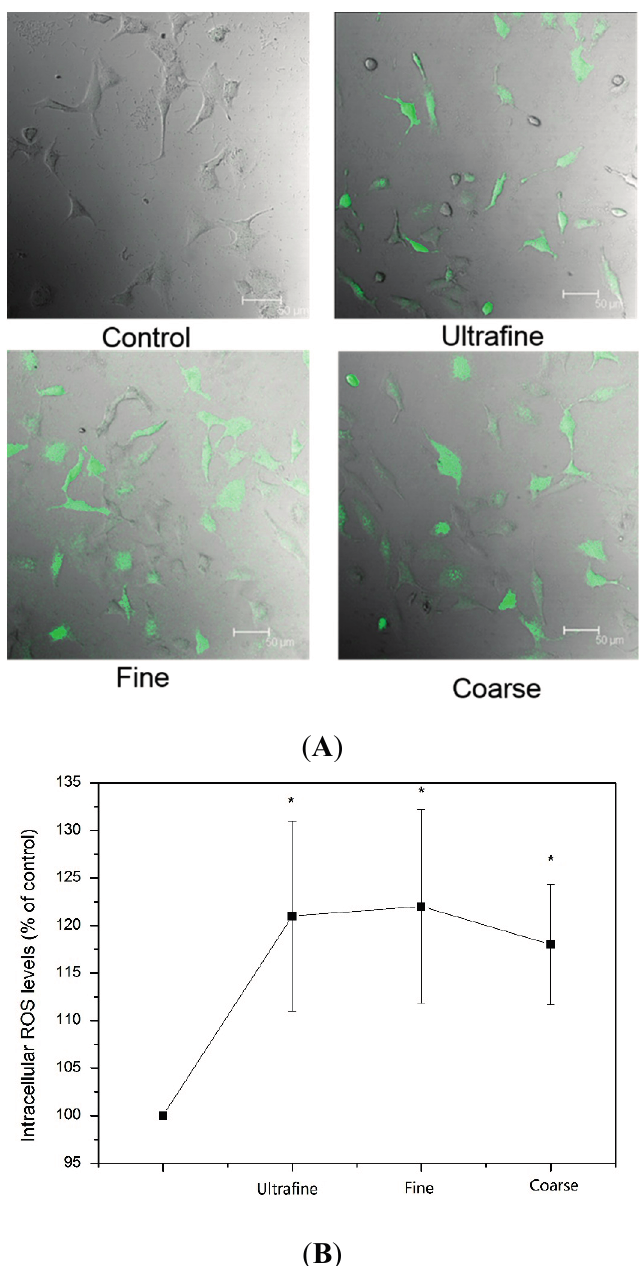
Figure 5. ( A ) LSCM (Laser Scanning Confocal Microscope) images and ( B ) intracellular reactive oxygen species (ROS) levels of A549 cells with PM samples (ultrafine, fine and coarse